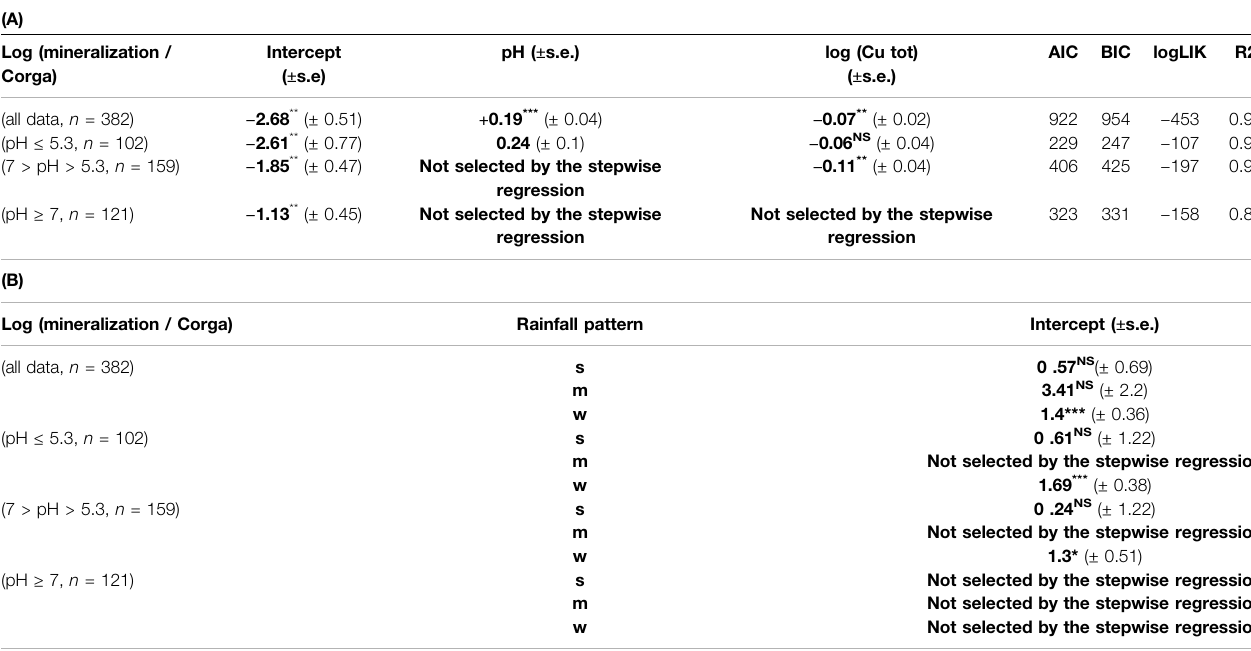
TABLE 2 | (A) Slope and intercept ± SE between log (mineralization/ Corga) and variables selected through stepwise analyses with the linear mixed model for different dataset (all data, data with pH ≤ 5.3, data with 7 > pH > 5.3 and data with pH ≥ 7) as well as the metrics associated to each model. (B) Shift of the intercept for log (mineralization/organic C) between the different groups of qualitative variable (rainfall pattern) (s (cid:2) dry summer, w (cid:2) dry winter) and the reference one (f (cid:2) humid all year long) Bold values are estimated coef fi cient through step wise